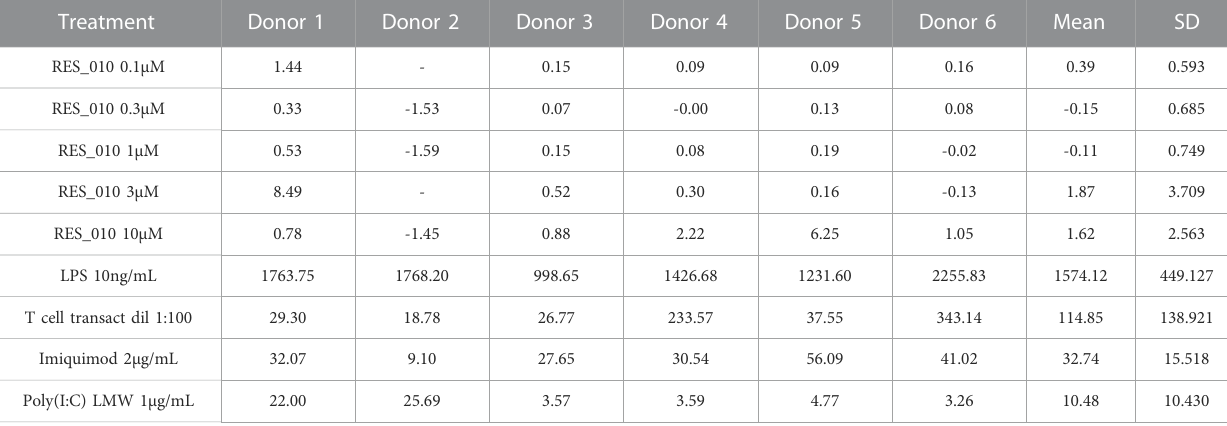
TABLE 4 Concentration Data Vehicle Corrected (pg/mL) for Cytokines: IL-1 β . Treatment Donor 1 Donor 2